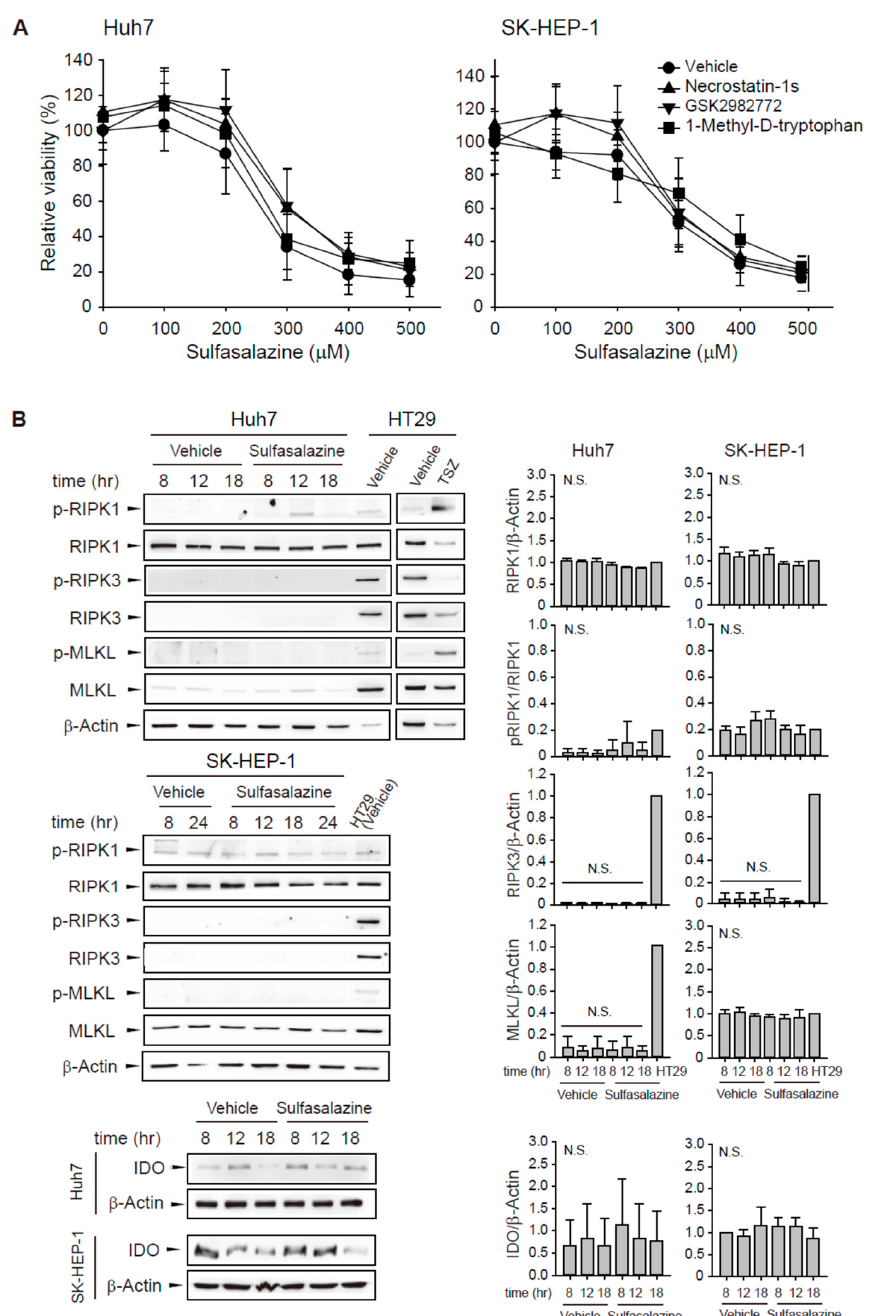
Figure 4. Other RIPK1 inhibitors and IDO inhibitor did not prevent the decrease in cell viability induced by sulfasalazine. ( A ) Huh7 and SK-HEP-1 cells were treated with vehicle (circle) or 20 µ M necrostatin-1s (RIPK1 inhibitor, triangle), 20 µ M GSK2982772 (RIPK1 inhibitor, inverted triangle), or 500 µ M 1-methyl-D-tryptophan (IDO inhibitor, square) for 1 h, followed by sulfasalazine in a dose-dependent manner for 24 h. Cell viability was measured with a CellTiter-Glo ® assay. ( B ) Cells were treated with 500 μ M sulfasalazine for indicated periods and subjected to Western blot analysis. HT29 cells treated with vehicle or TSZ (50 ng/ml TNF α , 1 μ M SM164 was 20 μ M Z-VAD-FMK) for 12 h as a positive necroptosis model. Relative expression was calculated in compared with vehicle (8 h) group for IDO or HT29 (vehicle) group for others. Each experiment was repeated 3 times in triplicate and data are expressed as means ± SDs. N.S., not significant.